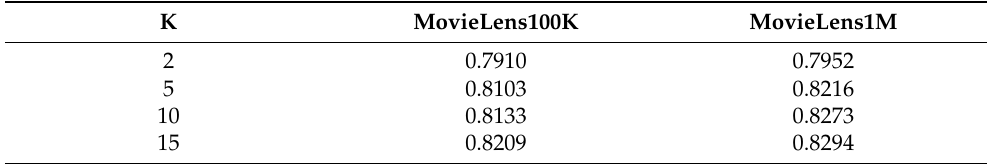
Table 9. The impact of list length on